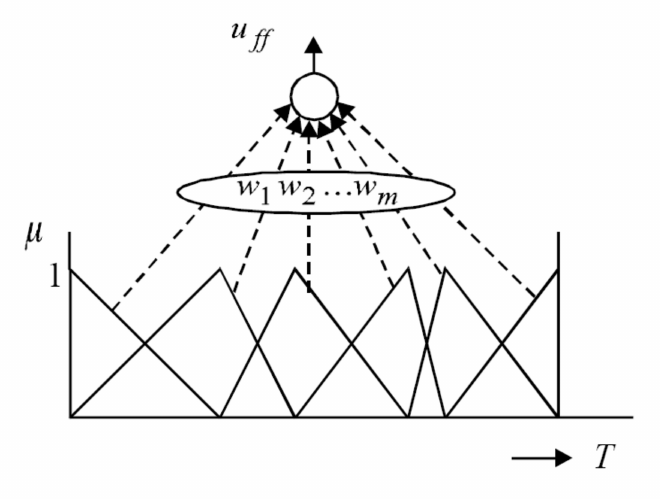
Figure 5. Approximation of the feedforward control signal using a second-order B-spline neural network